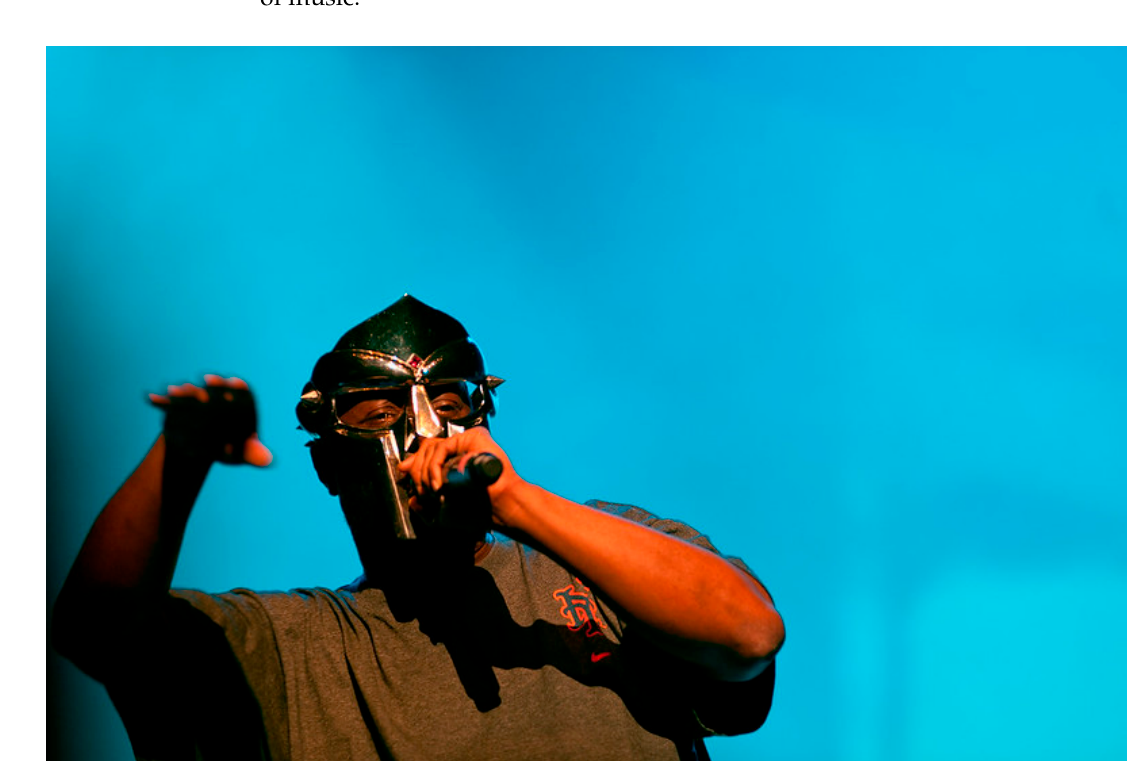
Figure 1. Doom Performs in Brussels in 2010. Photo by Kmeron. Creative Commons Attribution-NonCommercial-NoDerivs 2.0 Generic.